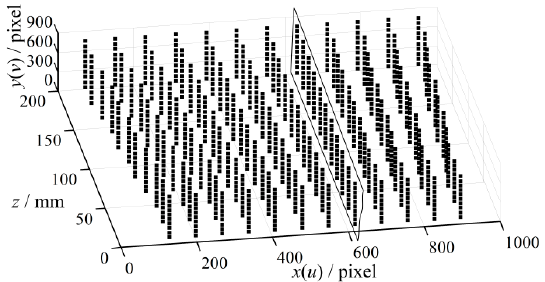
Figure 8. Distribution of the projection sampled points in CSEM.